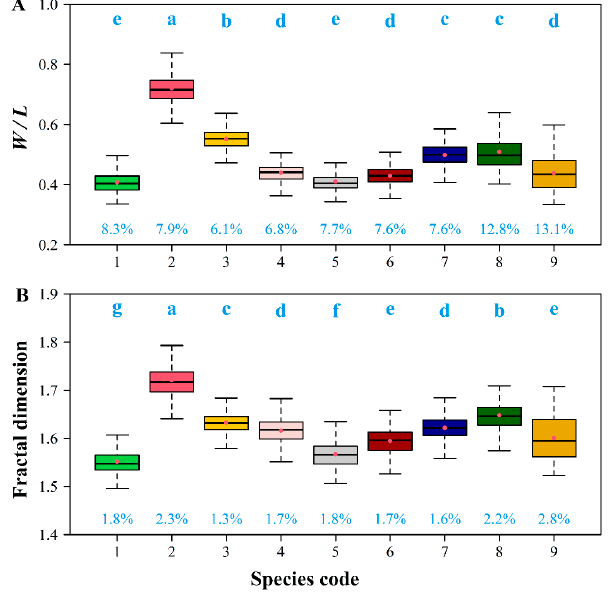
Figure 4. Boxplots of the ratio of leaf width to length ( A , W / L ratio) and leaf shape fractal dimension ( B , FD). The same lowercase letters indicate no significant difference in the W / L ratio or FD between any two species; the numbers represents the variation coefficients of the W / L ratio or FD.